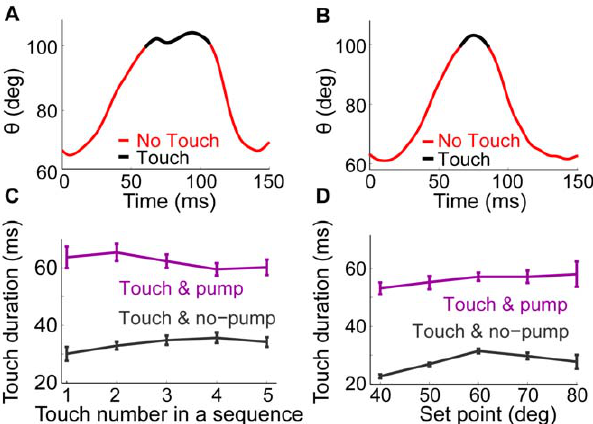
Figure 4. Contact durations are longer in whisks with TIP. A. A typical single whisk with a pump after touch onset. Period of whisker- pole contact marked in black. The pump occurred while the whisker stayed in contact with the pole. B. A typical single whisk without a pump after touch onset. C. Touch duration as a function of the position of the touch in a sequence of touches. Whisks with touch and TIP (purple) and whisks with touch but no TIP (gray). D. Touch duration with and without a TIP, as a function of the set